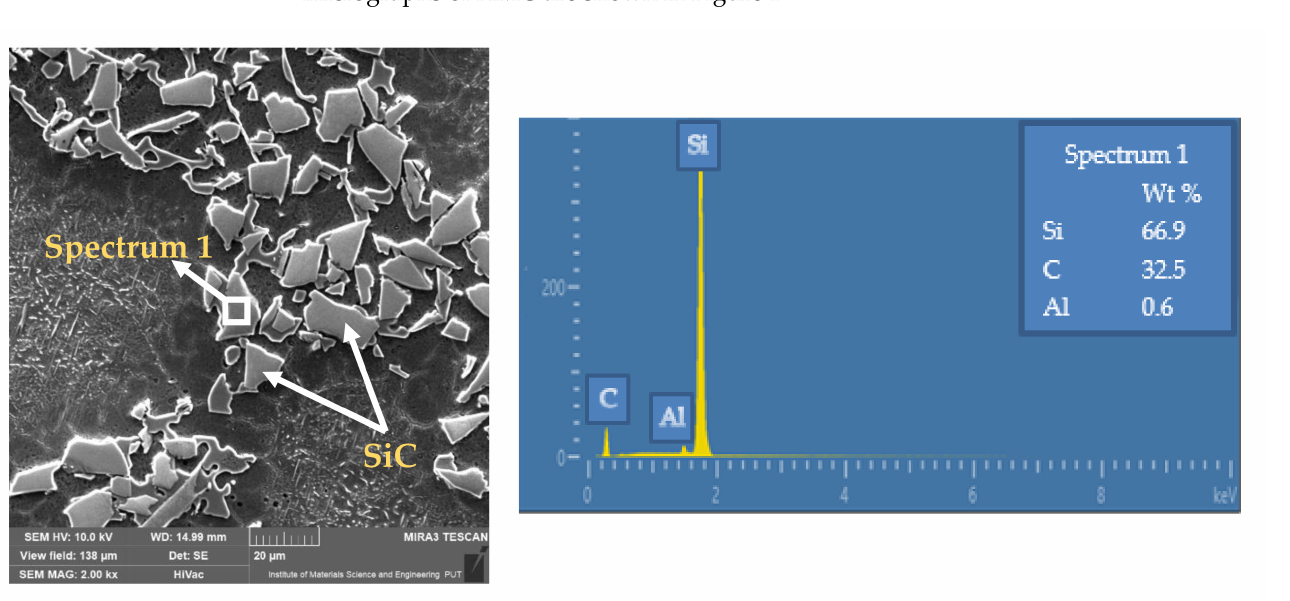
Figure 1. Metallographic microsections of F3S.10S composite and EDS micrographs of SiC powder.